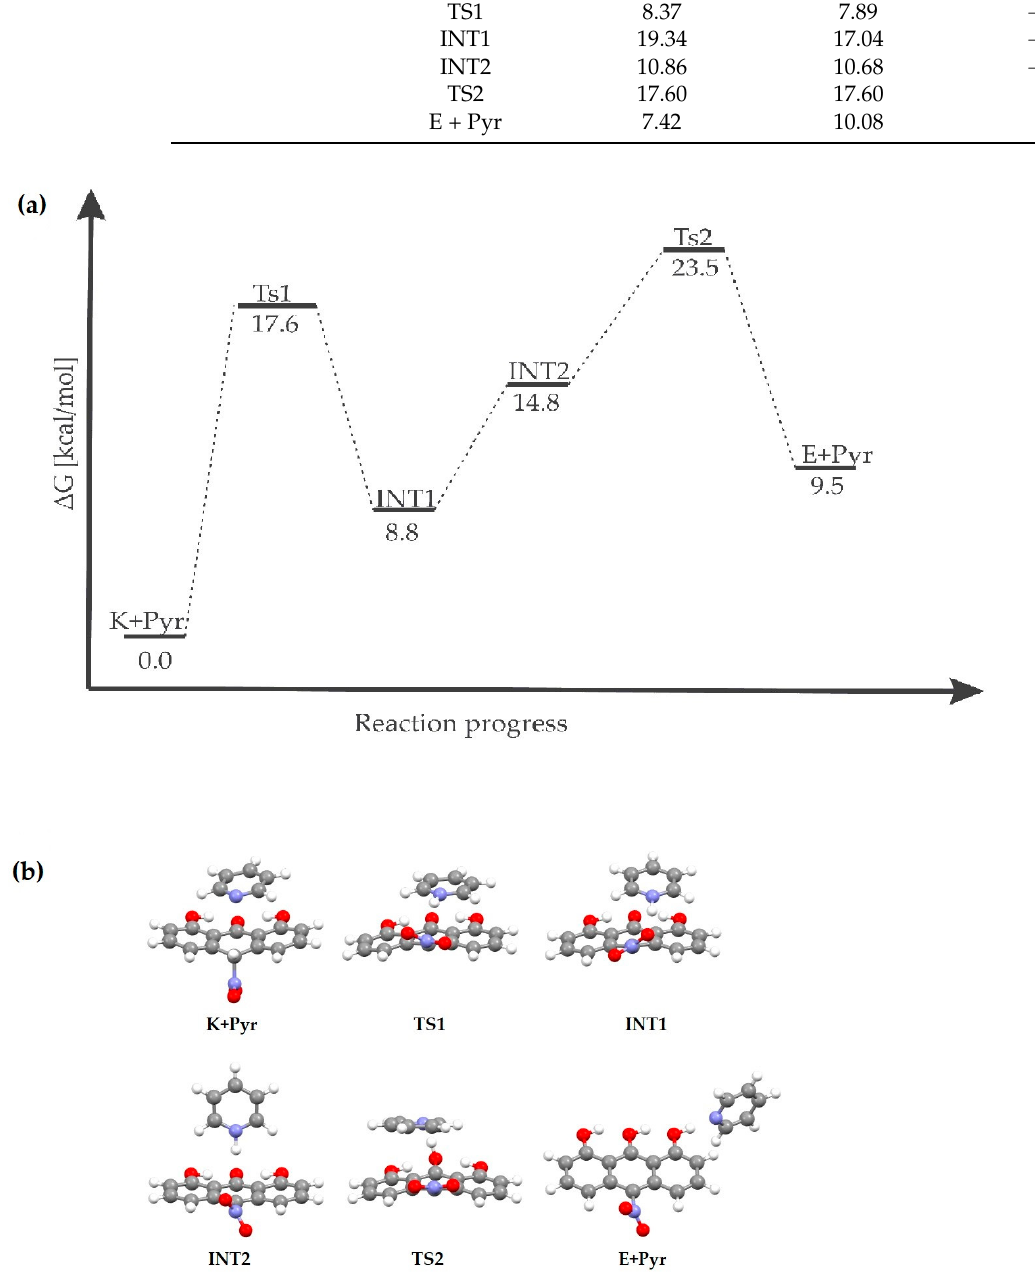
Figure 6. Steps of proton transfer reaction involving pyridine for 1,8-dihydroxy-9-anthrone with NO 2 substituent, ( a )—Reaction progress ∆ G [kcal/mol] at 298 K, ( b )—optimized structures.